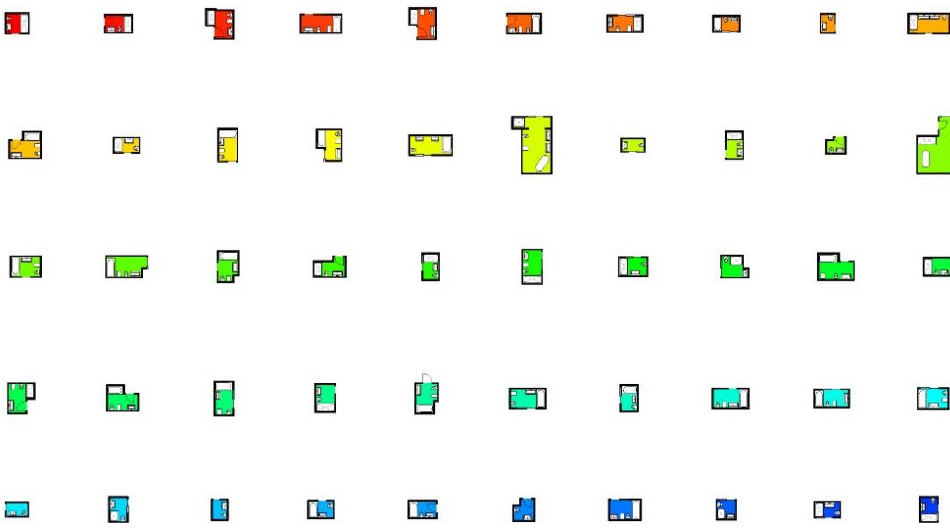
Figure 5. Floorplan view of the generated modules representative of each cluster.